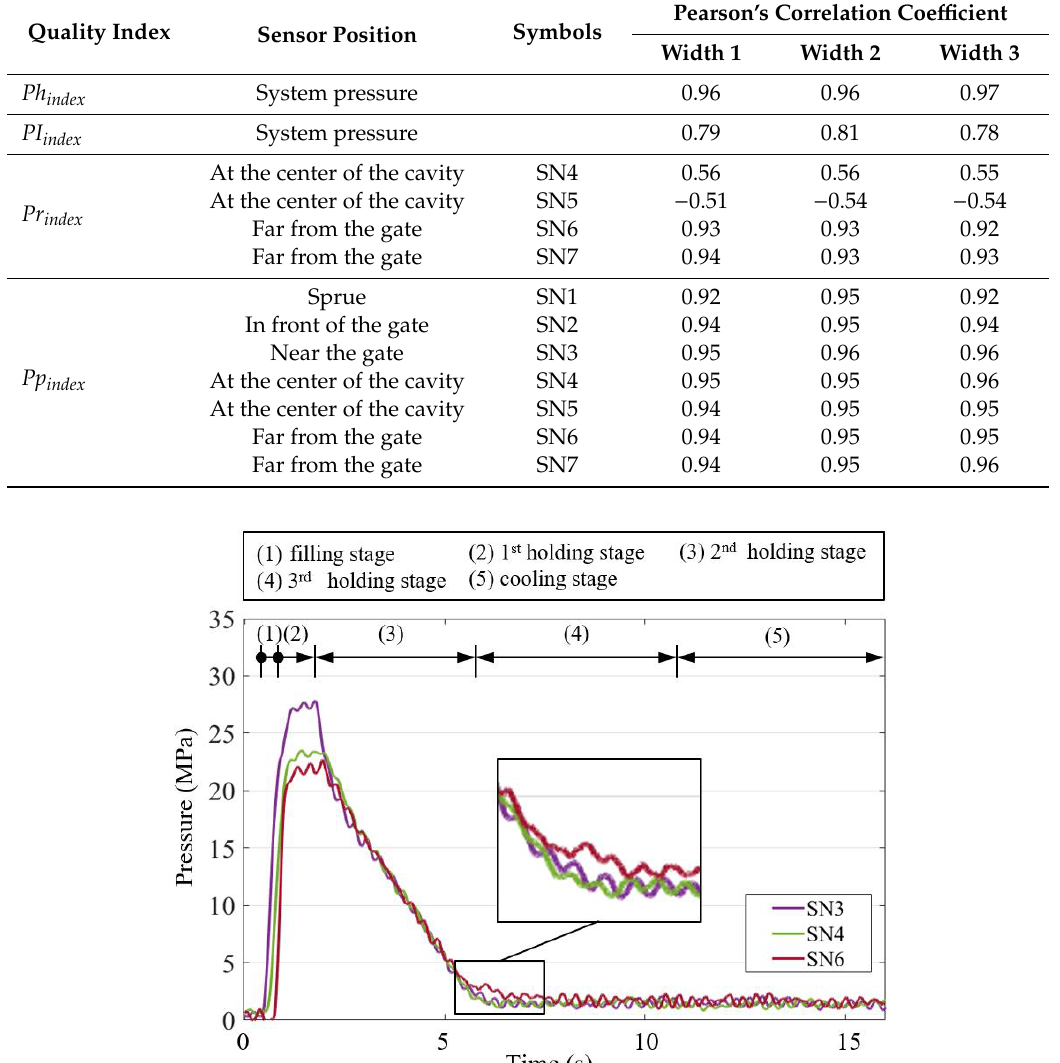
Table 5. PCCs between the geometric widths and quality indices.